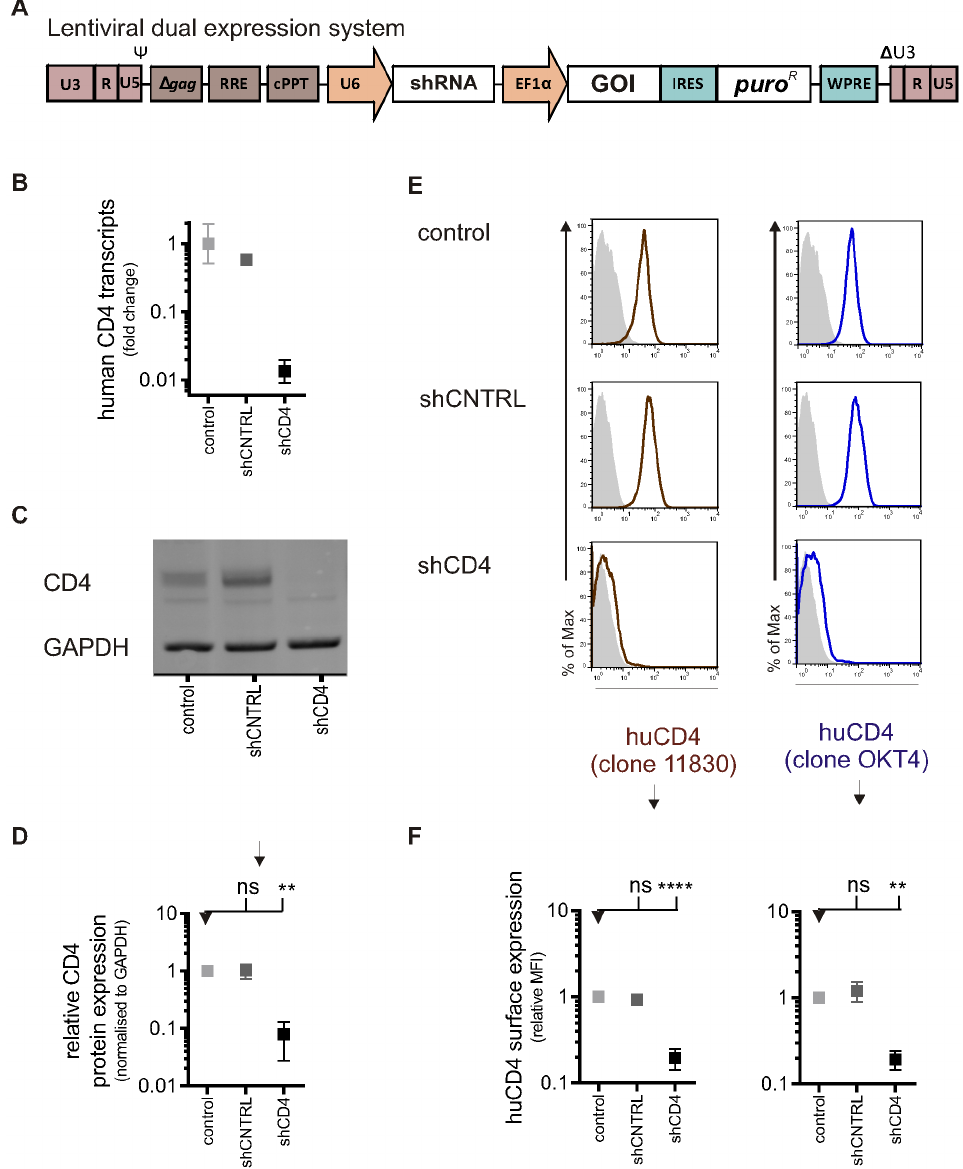
Figure 3. CD4 knock-down in genetically modified stem cell-derived macrophages. A) Schematic diagrams of self-inactivating lentiviral constructs used to express a shRNA (non-specific short-hairpin control (shCNTRL) or a short hairpin targeting CD4 (shCD4)) and puromycin resistance gene ( puro R ). The Gene Of Interest (GOI) linked to expression of Puromycin R can easily be cloned downstream from the EF1 a promoter. B) Detection of CD4 transcripts. RNA was isolated from control and transgenic PSC-macrophages and analysed by RT-qPCR. Symbols represent the relative mean number of copies of CD4 mRNA 6 SEM of technical replicates (n=3) using pooled RNA from three independent experiments. C) Detection of protein expression of CD4. Control and transgenic PSC-macrophages lysates were analysed by western blotting using anti-CD4 antibodies. GAPDH, a loading control, was detected using anti-GAPDH antibody. Representative blot is shown.D) Protein levels were measured with Odyssey software (Li-COR) and CD4 expression was normalised to GAPDH expression. Symbols represent mean normalised CD4 expression relative to the PSC-macrophages control group, 6 SEM (n=3 independent experiments). E) Detection of surface protein expression of CD4. Control and transgenic PSC-macrophages were tested for surface CD4 expression by flow cytometry using two different clones of anti-CD4 antibodies. Representative histograms showing CD4 surface staining with mAb clone 11830 (red/brown line, left panel) and with mAb clone OKT4 (blue line, right panel), both compared to isotype control (shaded gray). The expected phenotype (presence or absence of endogenous human CD4) in cells expressing this lentiviral vector is indicated by the symbols. F) Quantification of CD4 expression with mAb clone 11830 (left) and with mAb clone OKT4 (right) relative to the PSC-macrophages control group. The bars reflect the ratio of the geometric mean fluorescence intensity (MFI) over the isotype control 6 SEM of independent experiments (n=4). doi:10.1371/journal.pone.0086071.g003 considering that Popik et al. reported that irrespective of CD4 residues (RHRRR), may control CD4 partitioning to DRM palmitoylation a second region in the cytoplasmic tail of CD4, a [57]. Substitution of these five residues with alanine residues, short sequence of positively charged arginine and histidine resulting in a mutant referred to as ‘CD4 R- ’ in this study, excludes